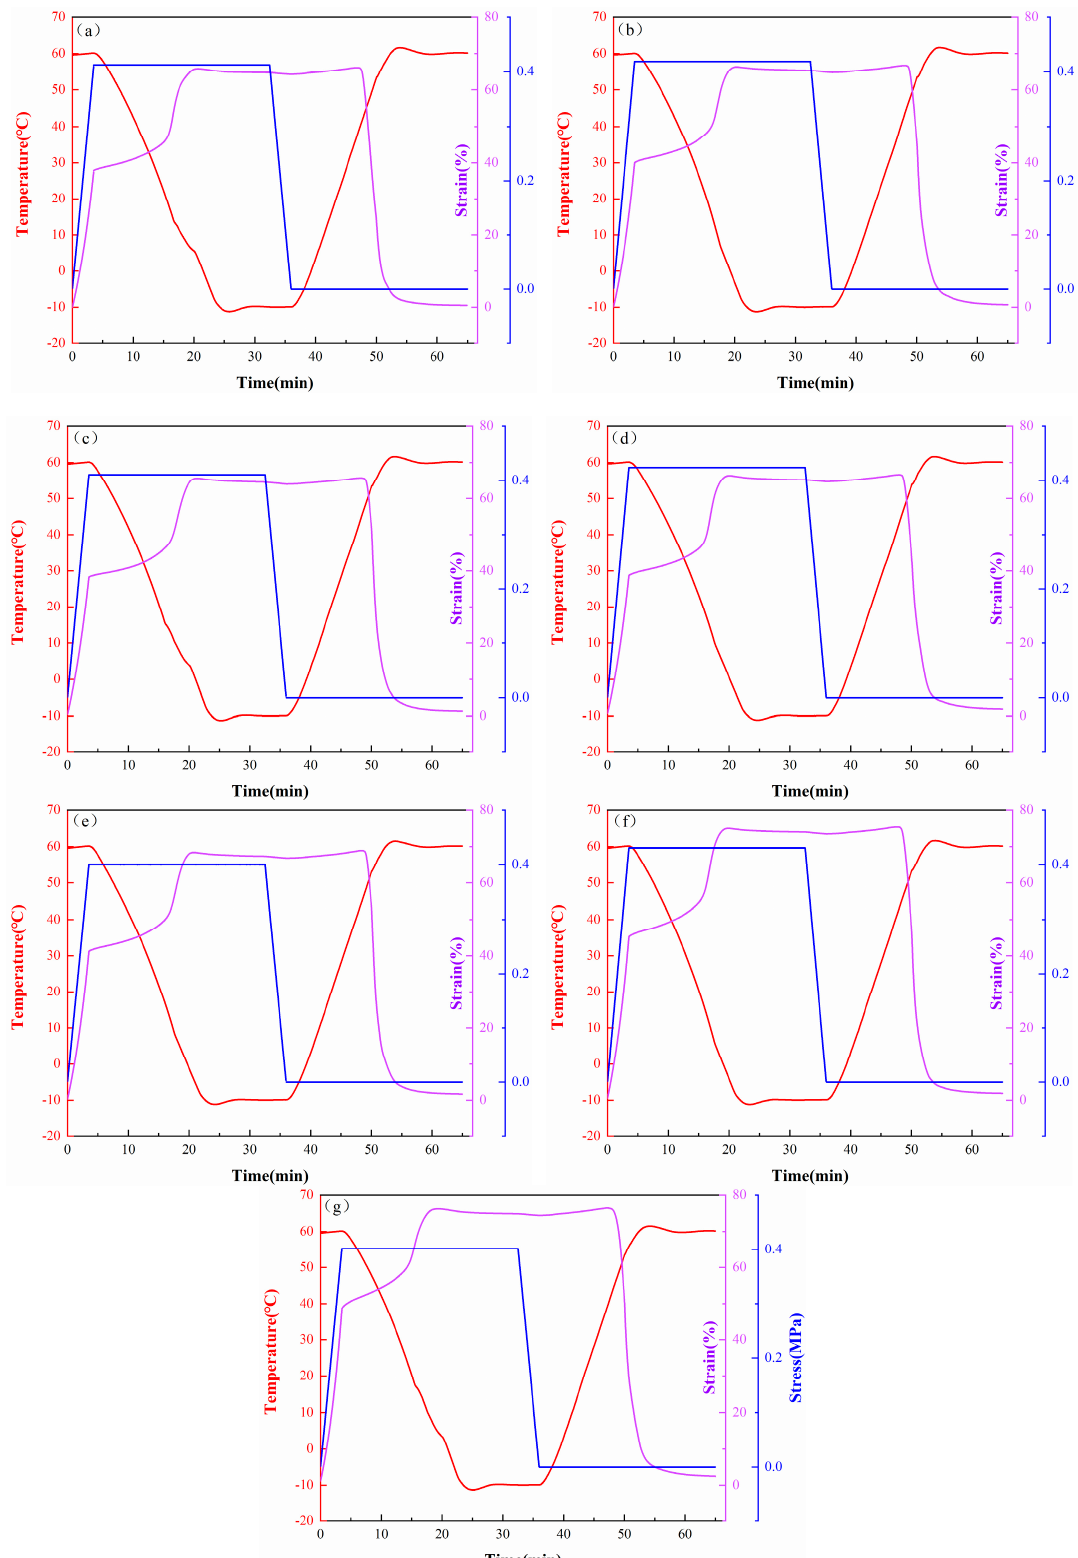
Figure 13. Shape-memory properties of TPI composites: ( a ) Neat TPI; ( b ) TPI with 0.6 phr CNTs; ( c ) TPI with 0.6 phr CNTs@PDA; ( d ) TPI with 1.2 phr CNTs@PDA; ( e ) TPI with 1.8 phr CNTs@PDA; ( f ) TPI with 2.4 phr CNTs@PDA; and ( g ) TPI with 3.0 phr CNTs@PDA. Table 4. Shape-memory performance parameters for TPI composites.